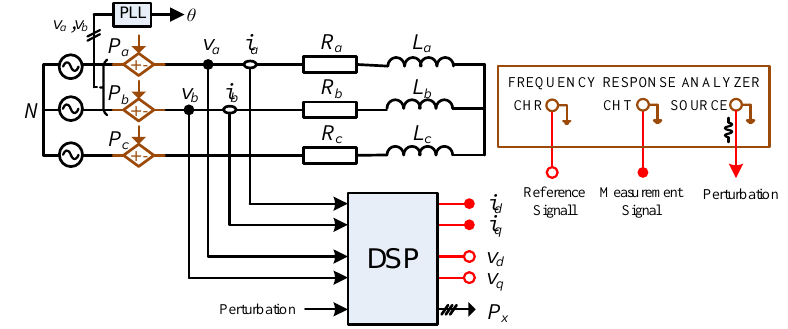
Figure 6. Z -parameter measurement set-up for the three-phase AC−AC network.